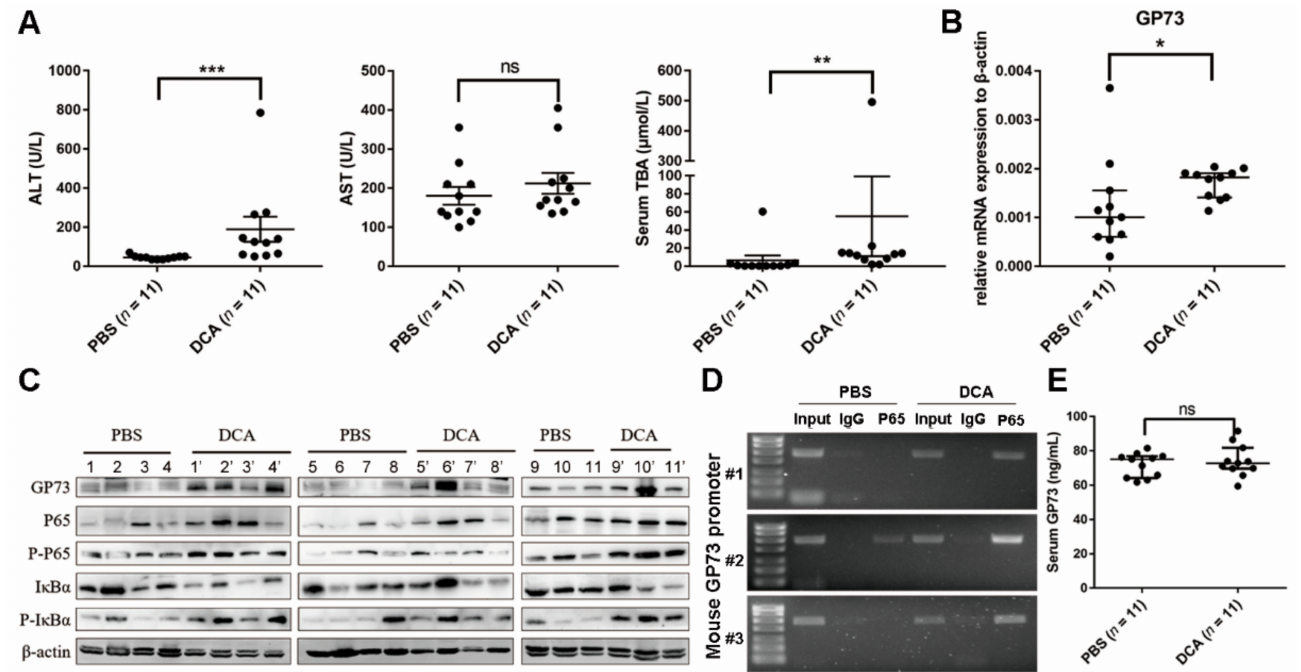
Figure 5. Deoxycholic acid (DCA) upregulating Golgi protein (GP73) expression through NF- κ B pathway in mice. ( A ) Male C57BL/6 mice were sacrificed at 21 days after being administered phosphate-buffered saline (PBS) or DCA. ALT, AST, and TBA in serum were analyzed. ( B ) qRT-PCR analysis was carried out to determine GP73 expression level in liver tissues of C57BL/6 mice administered with PBS or DCA for 21 days. ( C ) GP73 and NF- κ B pathway proteins of C57BL/6 mice administered PBS or DCA for 21 days were determined by WB (11 mice for each group). ( D ) ChIP-PCR assay to determine the binding of NF-kB P65 on GP73 promoter in mouse liver tissues. Three liver tissues from PBS and DCA administration group were randomly selected. The products of ChIP-PCR in the input, IgG, and ChIP groups were analyzed using agarose gel electrophoresis. ( E ) Serum GP73 levels were determined by ELISA. Data in ( A , B , D ) are expressed as the mean ± SEM (* p < 0.05; ** p < 0.01; *** p < 0.001; ns: not significant). Statistical analysis was performed using GraphPad